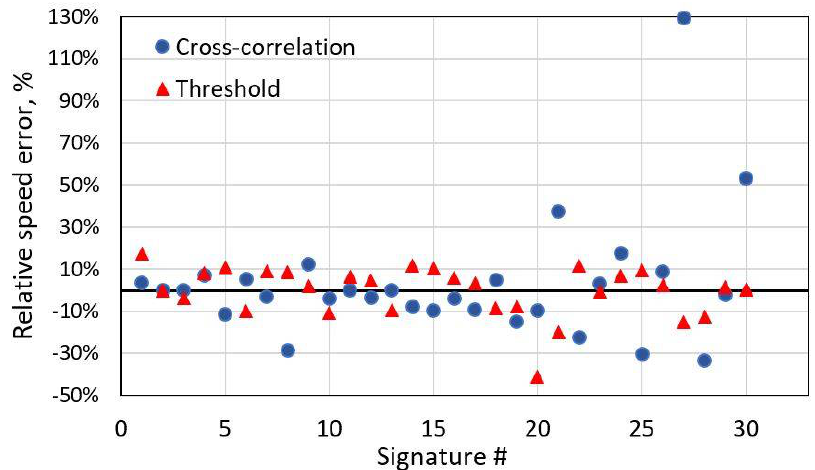
Figure 7. Relative speed error of the test group with distorted signatures with two methods. Relative speed error standard deviation for the cross-correlation method is 30%; for the threshold-based method, it is 12%.